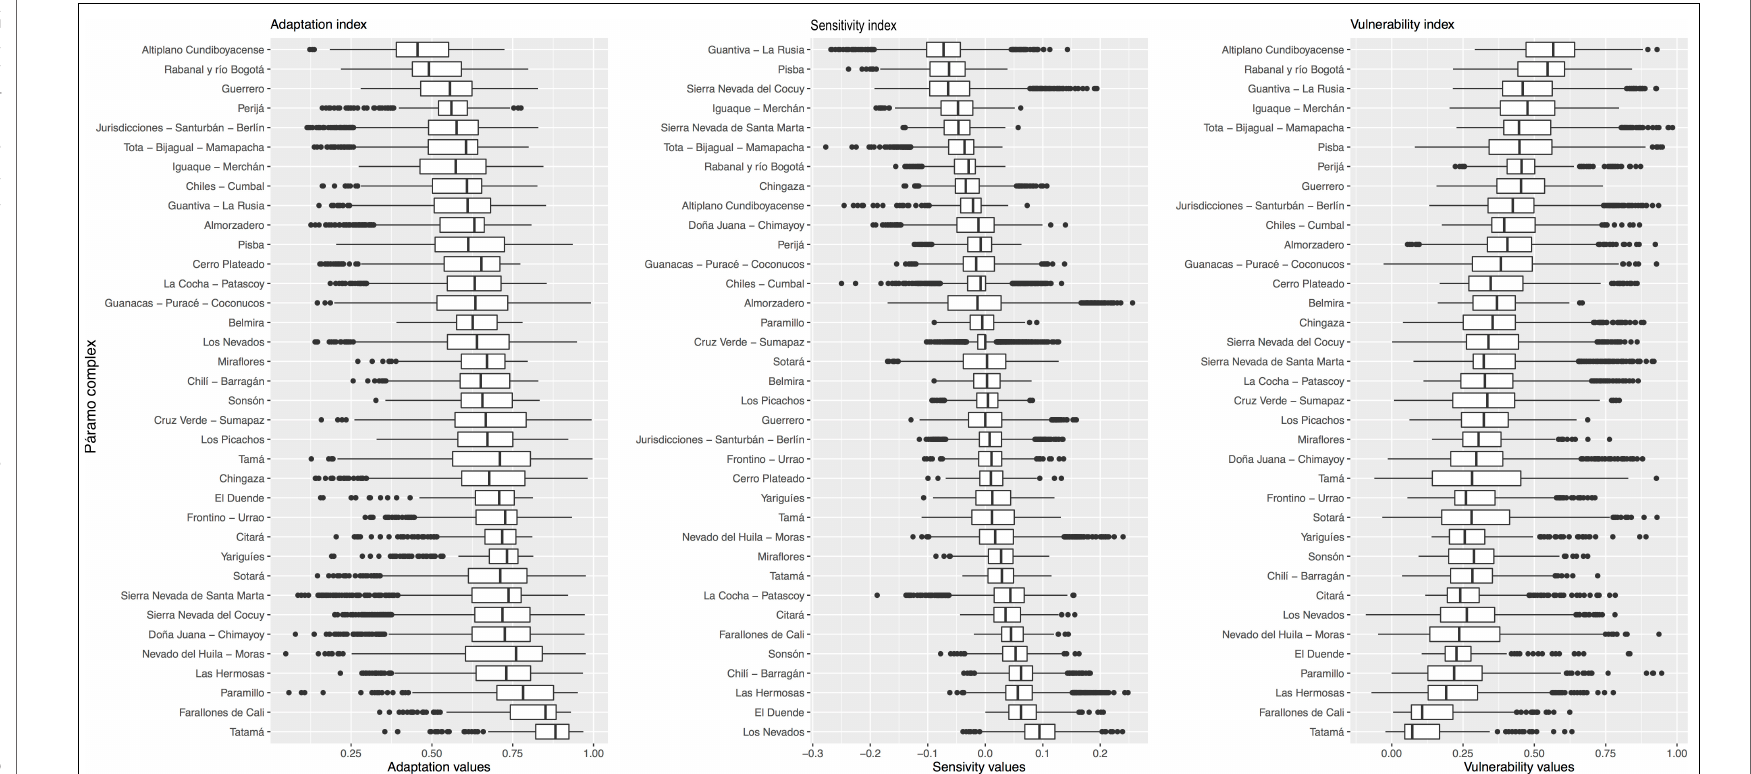
FIGURE 5 | Boxplots for the adaptive capacity (A) , climate sensitivity (B) , and vulnerability (C) across 36 Páramo complexes in the Colombian Andes. For comparative purposes, Páramo complexes are sorted in (A) from those with a low adaptive potential to anthropic pressures according to the enhancing and limiting factors depicted in Figure 3 , in (B) from those likely to experience a range loss (distributions below zero) to those predicted to exhibit a range gain (distributions above zero) by 2050 (under RCP 8.5), while in (C) Páramo complexes at the top are the most vulnerable. Boxplots summarize grid estimates depicted in Figure 4